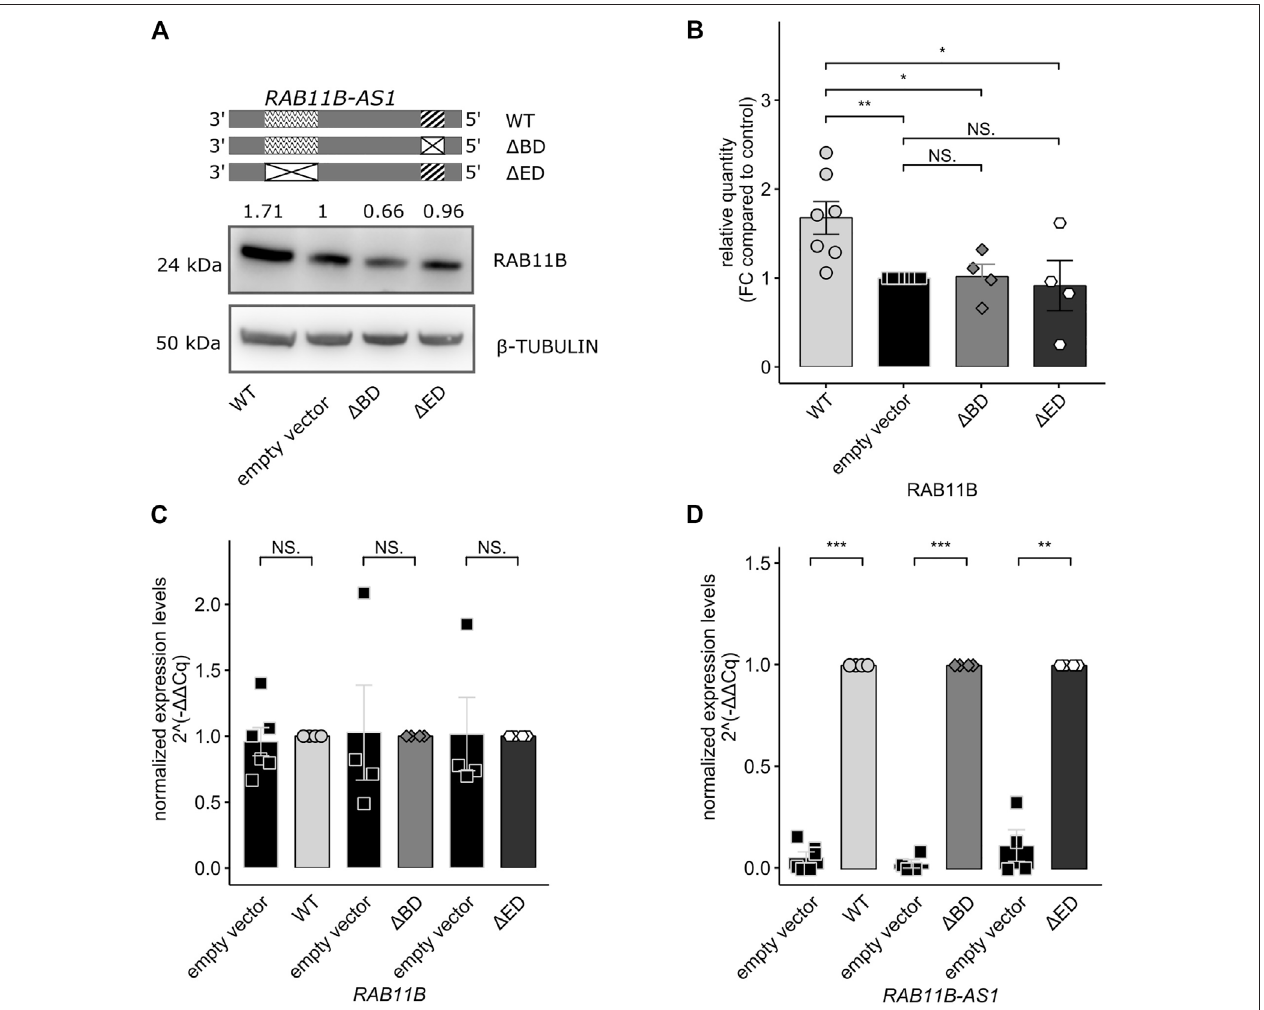
FIGURE 4 | Deletion of functional SINEUP domains (BD, ED) impairs RAB11B-AS1 effect on RAB11B protein translation. (A) The RAB11B-AS1 (WT, Δ BD, and Δ ED)sequenceschematicsreportthelocationoftheputativeSINEUPdomains(up).RepresentativeimagedescribesaWesternBlotofRAB11Bafter RAB11B-AS1 WT, Δ BD,and Δ EDover-expression. β -TUBULINwasusedasloadingcontrol. (B) BarplotofRAB11Bdensitometricanalysis,con fi rmingthatproteinincreasewasstatistically signi fi cant upon over-expression of RAB11B-AS1 (WT), while deletion mutants over-expression caused no protein expression difference from the control empty vector. (C) The barplot shows RAB11B transcriptional levels, tested by qPCR and expressed as 2 − ΔΔ Cq . mRNA levels were stable upon plasmid constructs over- expression (WT (cid:1) black, Δ BD (cid:1) light grey, Δ ED (cid:1) dark grey) with respect to the control empty vector (white). (D) RAB11B-AS1 was abundantly and signi fi cantly overexpressed upon plasmid delivery (WT (cid:1) black, Δ BD (cid:1) light grey, Δ ED (cid:1) dark grey) with respect to the control (white). Data are plotted as Mean ± SEM, N (cid:1) 4 for deletion mutants, N (cid:1) 6 for WT over-expression. For statistical analysis, un-paired one-tailed Student ’ s t -test was performed. NS p > 0.05, * p ≤ 0.05, ** p ≤ 0.01, *** p ≤ 0.001.